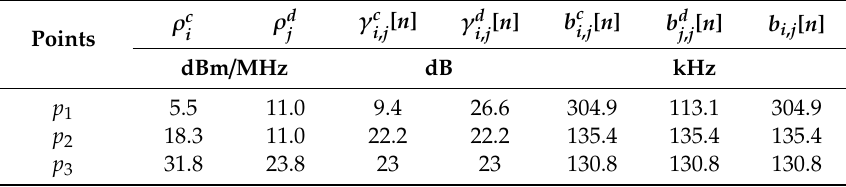
Table 1. Observation at three representative points in the feasible region.